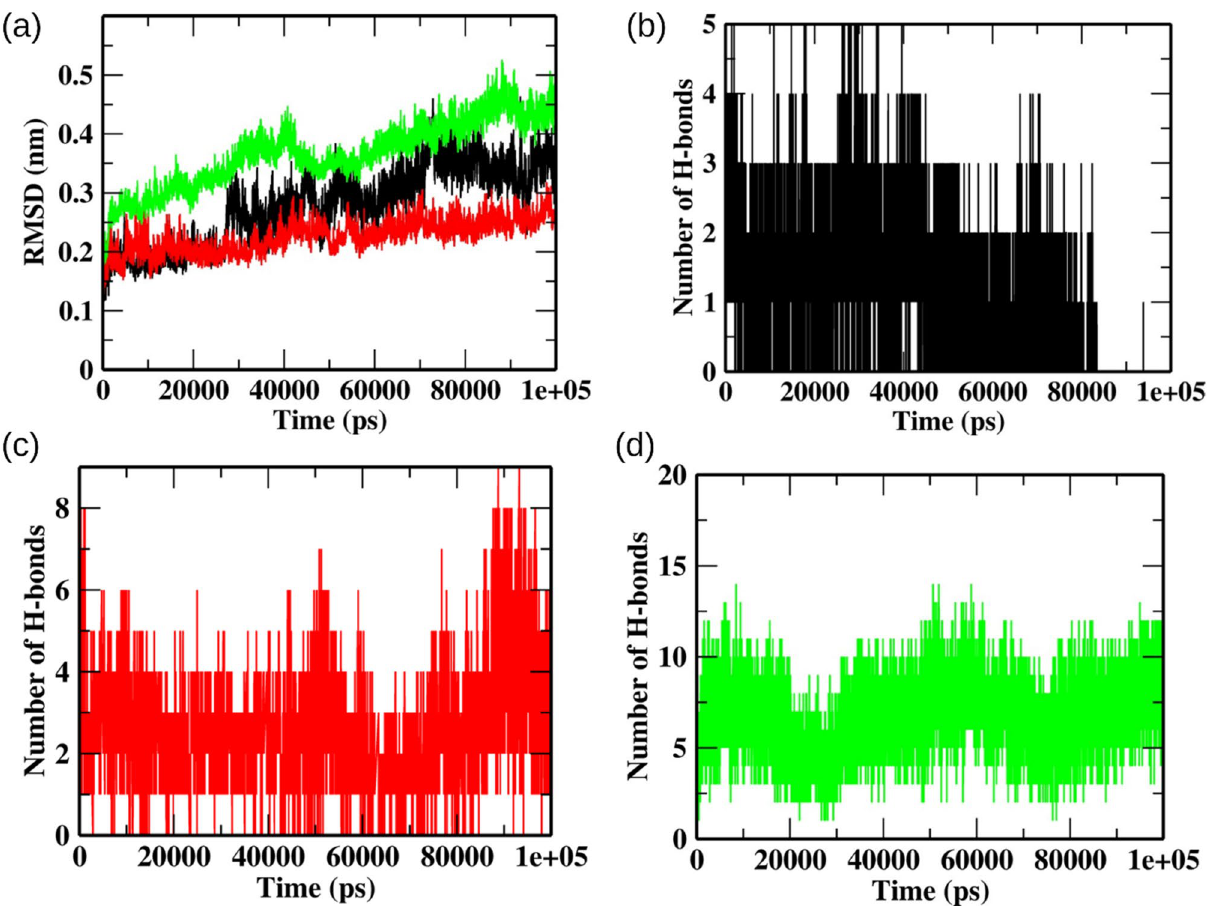
Figure 4. Analysis of MD trajectories. ( a ) RMSD of backbone Cα atoms and ( b – d ) number of H-bonds formed between M pro and ligands during the entire simulation. The color-coding scheme is as follows: GC373 (black), theaflavin (red), and theaflavin 3-gallate (green).